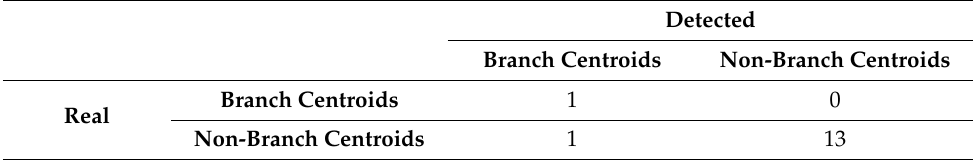
Table 5. The confusion matrix of real and detected branch centroids using the maximum entropy TSM.